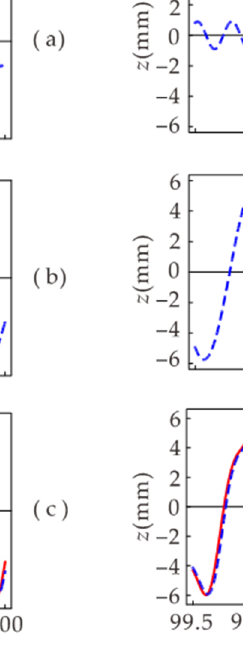
Figure 11. Displacement time-domain diagram: displacement time-domain diagrams when the excitation frequency f = 14 Hz and f = 17.5 Hz, respectively. ( a , d ) represent primary harmonic; ( b , e ) represent 1/3 harmonic. ( c , f ) represent the 1/3 subharmonic resonance. The conditions for 1/3 subharmonic resonance of the system are discussed below.